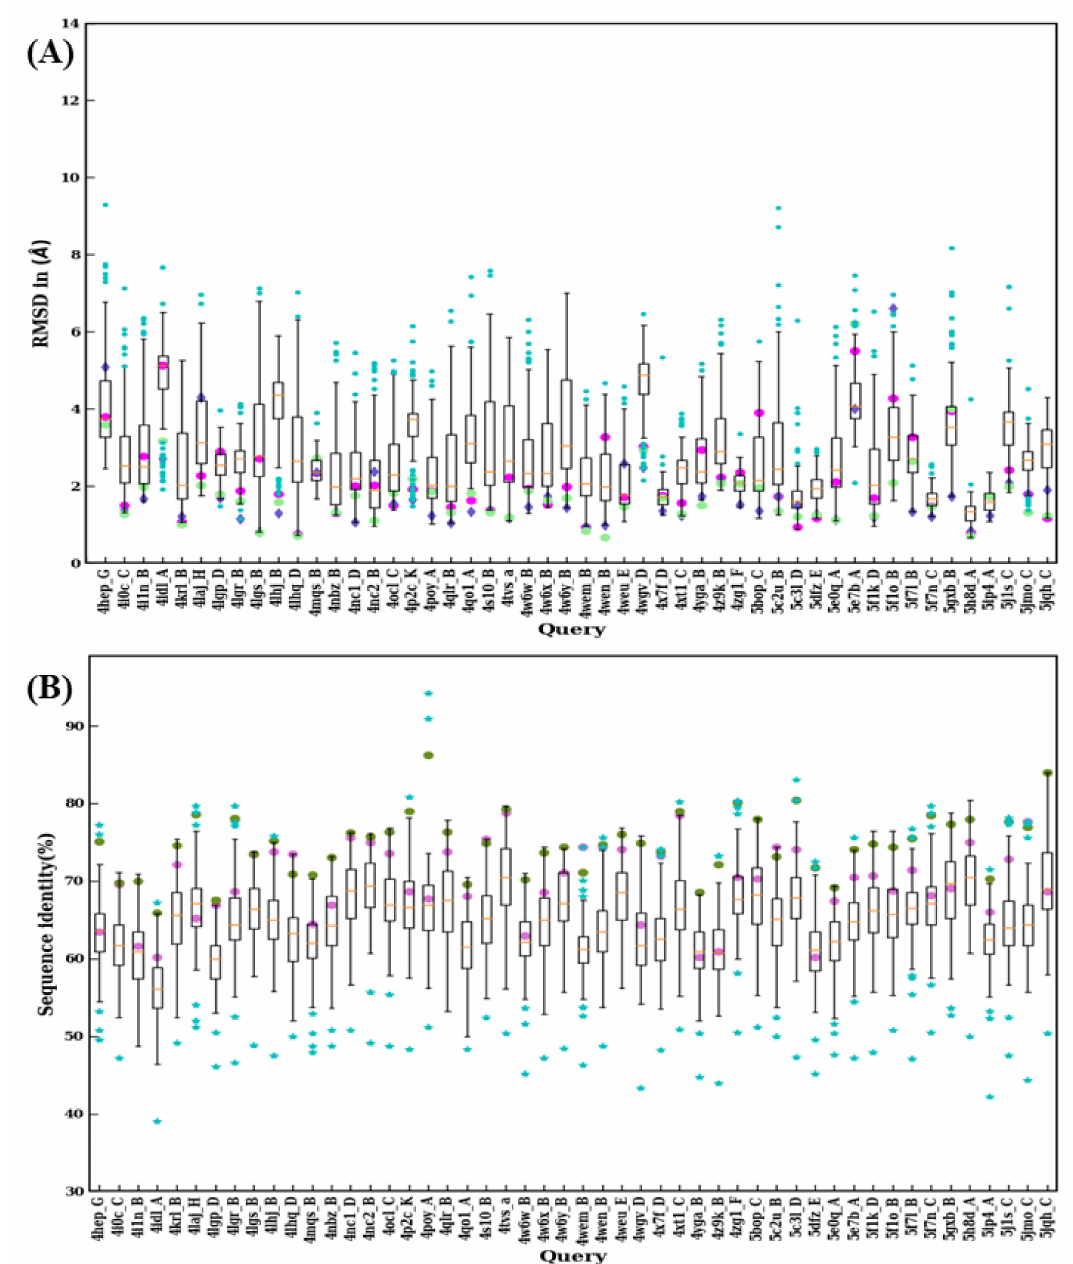
Figure 10. Structural similarity and sequence identity for last 50 V H Hs. ( A ) RMSD of best models from 99 modeling cases computed against the crystal structure. The RMSDs of best models from scenario 1, 2, and 3 are marked in magenta, purple, and green, respectively. ( B ) The values of sequence identities are shown. The sequence used in scenario 1 is in cyan at the upper limit, the one for scenario 2 is represented by a pink circle, and an olive green circle represents the average of the sequence identities, of the templates used for scenario